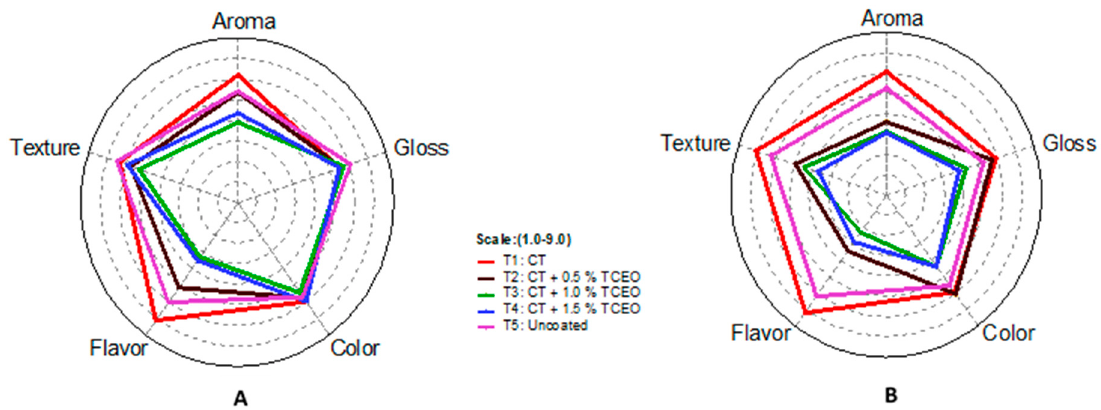
Figure 13. A hedonistic scale of strawberries with CT-TCEO on day 4 ( A ) and day 7(